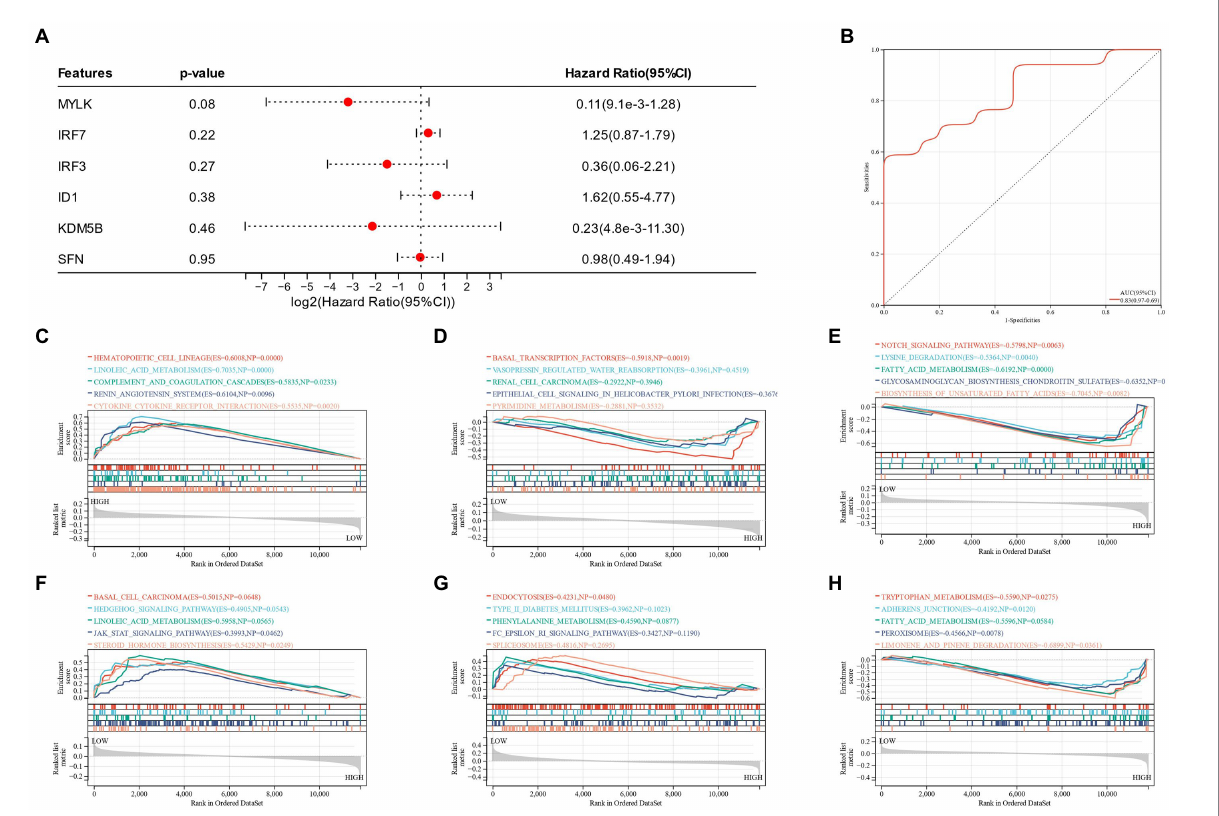
FIGURE 8 (A) Nomogram of candidate genes in the test group; (B) : ROC curves of nomogram of the test group; (C – H) : GSEA reveals the enrichment pathway of candidate genes.